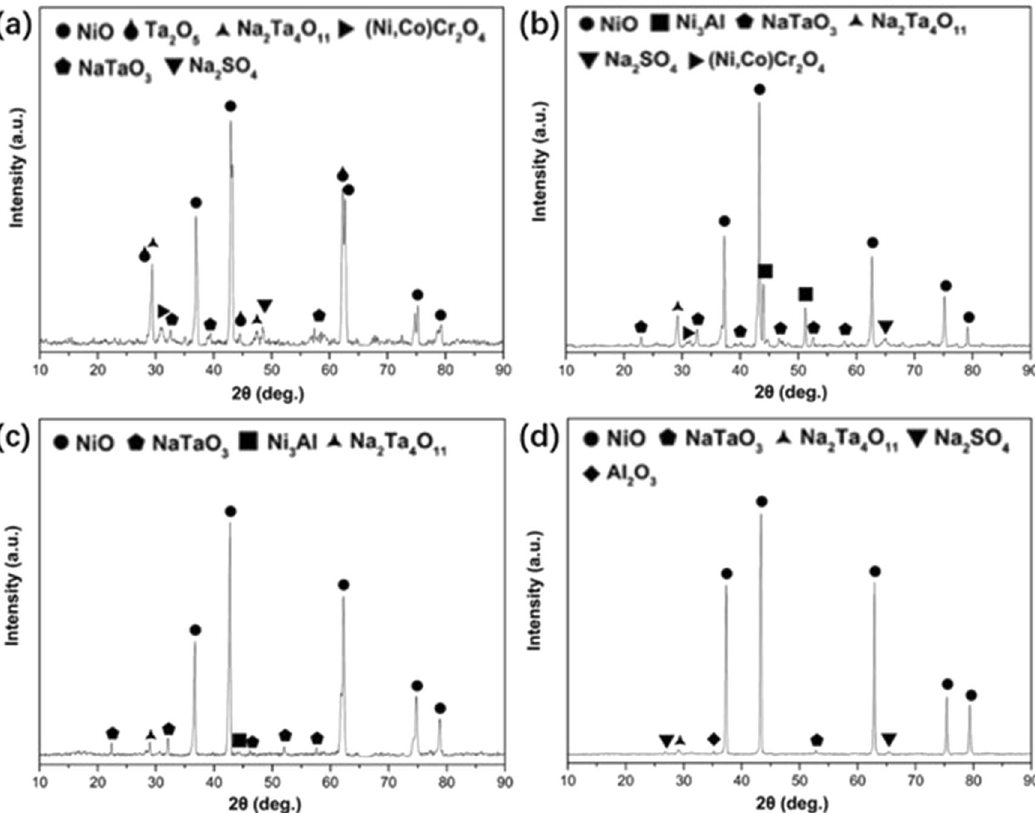
Fig. 5 The XRD patterns of the surface corrosion products around the hole after hot corrosion after drilling at 900 °C. a 20 h, b 50 h, c 100 h, and d 200 h.